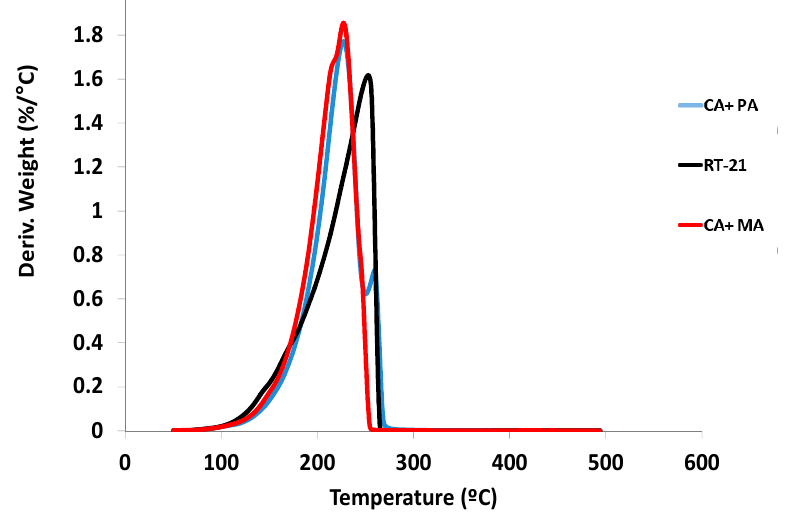
Figure 2. Derivative thermogravimetric curves of the PCM.